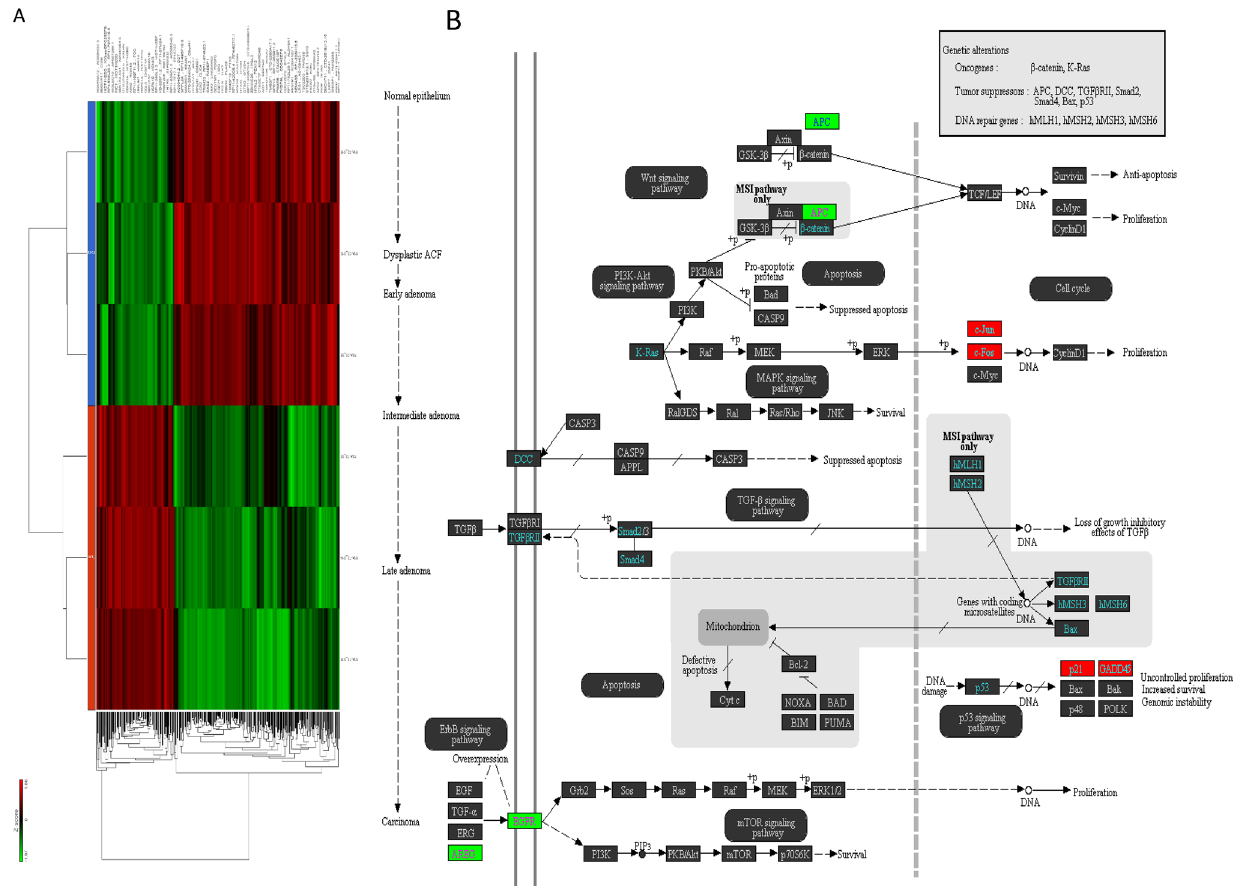
Figure 2. Riluzole regulates Wnt-β-catenin and mitochondrial pathways by RNA-Seq. Pancreatic cancer cells (MIA PaCa-2) were treated with Riluzole for 36 h. RNA was isolated. RNA-Seq was performed as described in Materials and methods. ( A ), Heat Map. Differential expression of genes in MIA PaCa-2 cells treated with or without riluzole. ( B ), Data analysis identified modulation of Wnt-β-catenin and mitochondrial pathways by riluzole in pancreatic cancer